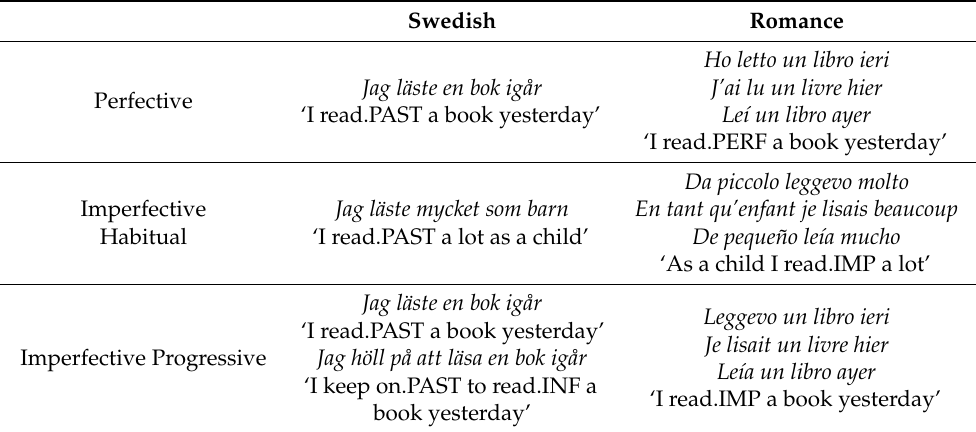
Table 1. Codification of perfective, imperfective habitual and imperfective progressive aspect in Swedish and Romance languages (Italian, French,